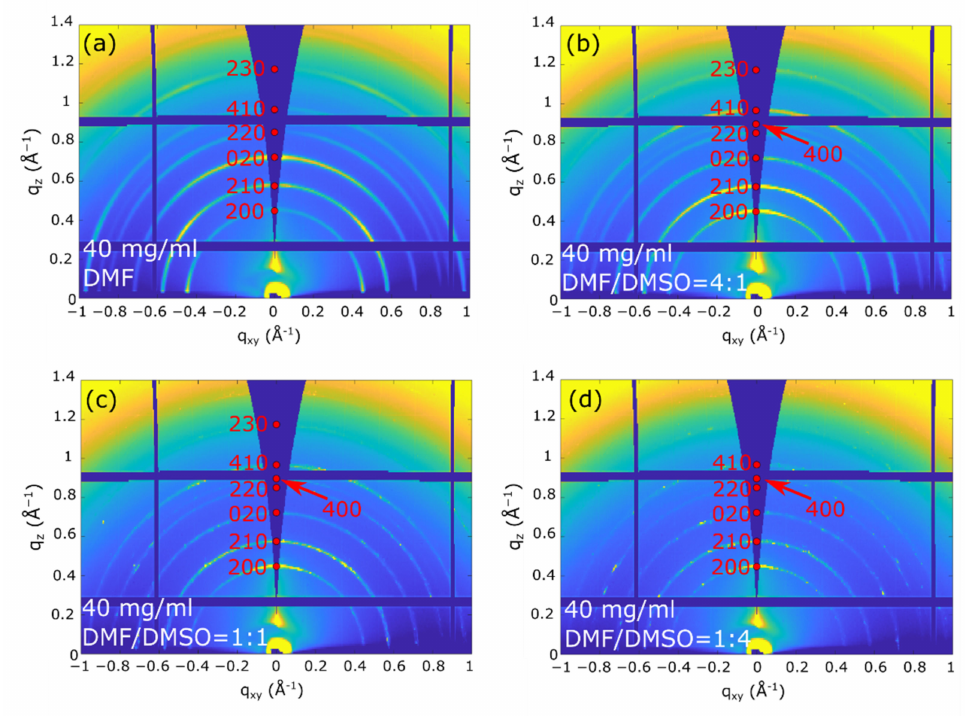
Figure 3. 2D-GIXD images taken at 0.2 ◦ on the (PRSH)PbBr 3 films prepared with different DMF/DMSO solvent volume fractions: DMF ( a ), DMF/DMSO = 4:1 ( b ), 1:1 ( c ), and 1:4 ( d ). The reflection indices and the q positions of the bulk phase are indicated in red.